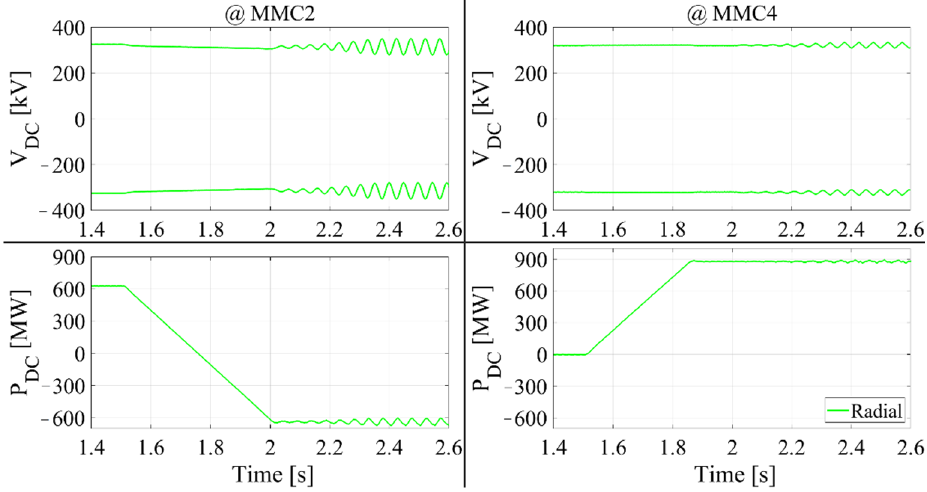
Figure 15. Time-doma in verification for